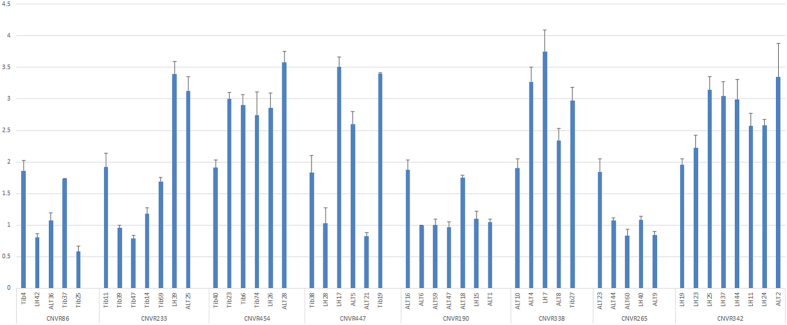
Normalized ratios (NRs) obtained by QPCR for 8 CNVRs.The y-axis shows the NR values obtained by QPCR, and the x-axis shows the sample names in the different CNV regions. Samples with NRs of approximately 2 denote normal individuals (two copy), samples with NRs of approximately 1 denote one-copy-loss individuals (one copy), and samples with NRs of approximately 3 or more denote copy-number-gain individuals.